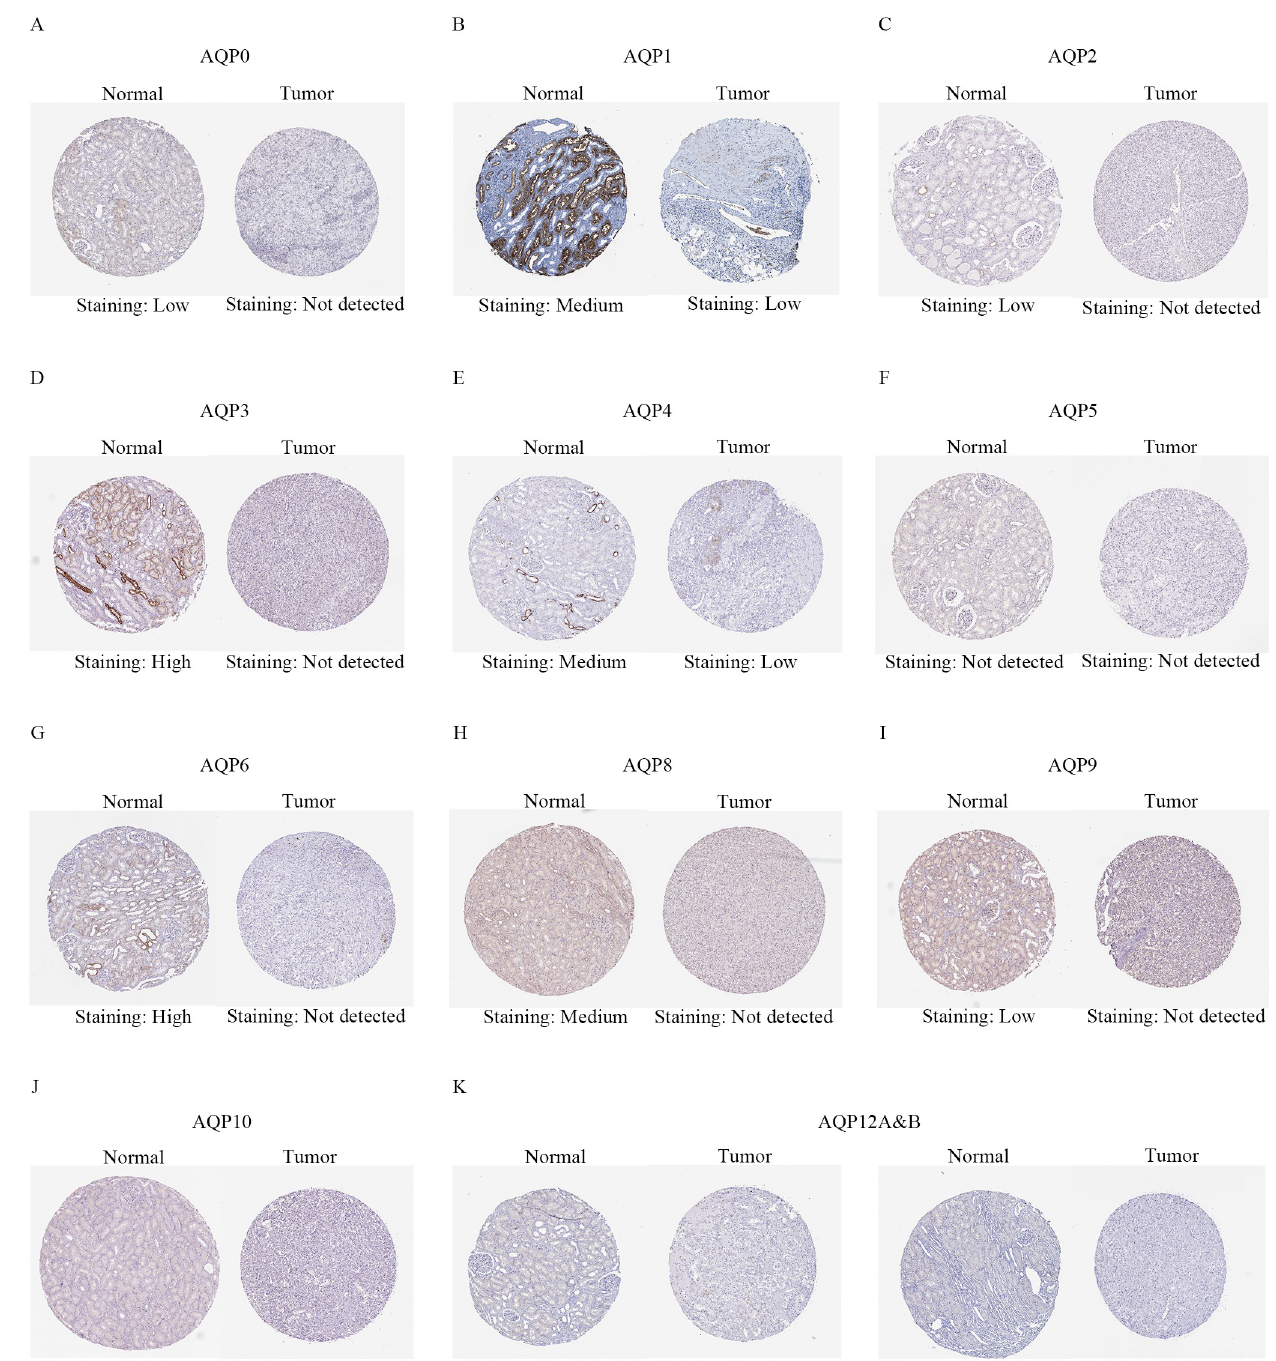
Fig 3. Representative immunohistochemistry images of AQPs in ccRCC and normal kidney tissues (Human Protein Atlas). ( A, C, D, G–I ) AQP0/2/3/6/ 8/9 proteins were not expressed in ccRCC tissues, whereas their low, medium and high expressions were observed in normal kidney tissues. ( B, E ) Low protein expressions of AQP1/4 were found in ccRCC tissues, while their medium protein expressions were observed in normal kidney tissues. ( F, J, K ) AQP5/10/12A&B proteins were expressed neither in ccRCC nor normal kidney tissues. Republished from https://www.proteinatlas.org/ under a CC BY license, with permission from inger å hle´n, original copyright